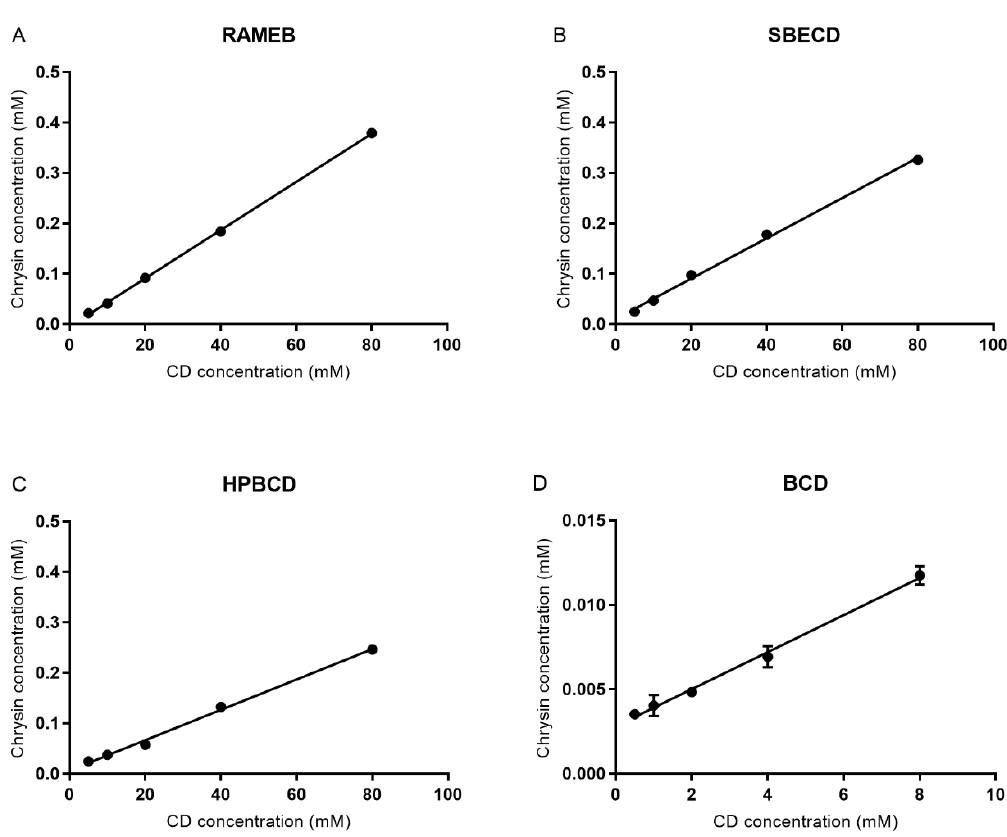
Figure 3. Phase-solubility diagrams of chrysin with ( A ) RAMEB, ( B ) SBECD, ( C ) HPBCD, and ( D ) β CD.